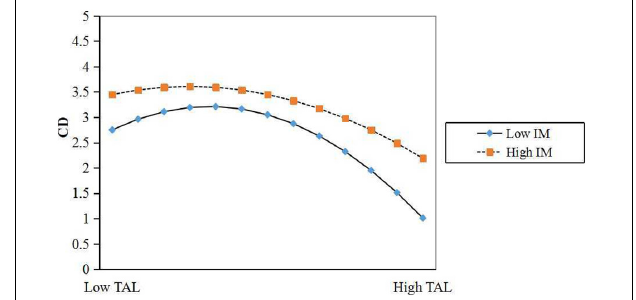
FIGURE 3 | The moderating role of individual mindfulness on the relationship between team authoritarian leadership and creative